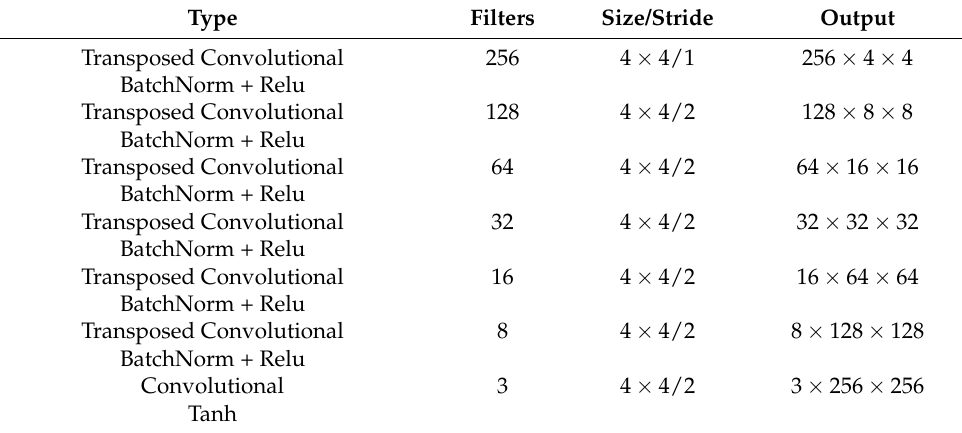
Table 2. The structure of